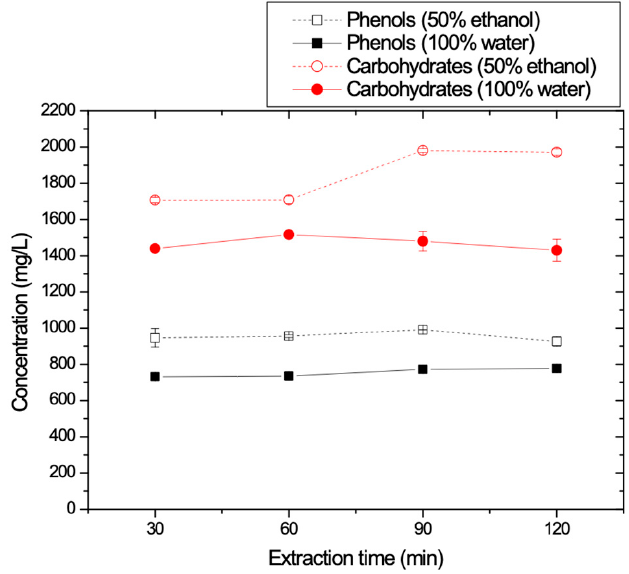
Figure 8. TPC and carbohydrates concentrations as function of the duration of extraction.